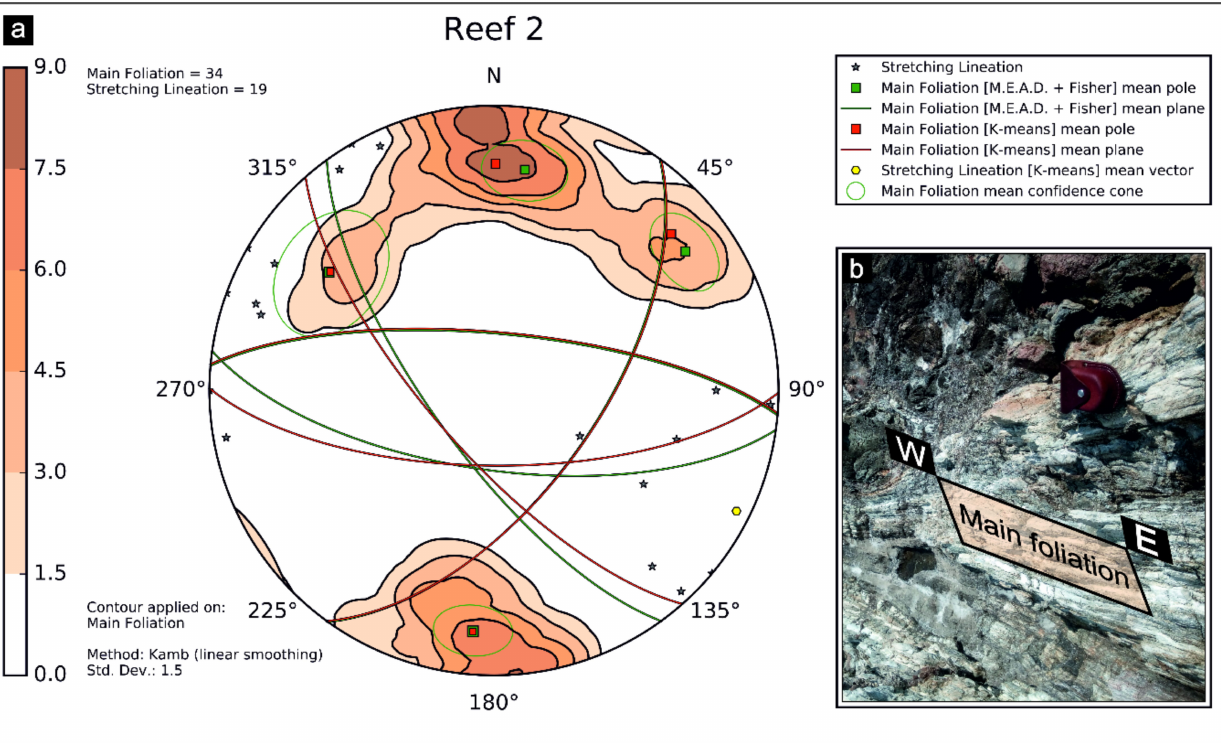
Figure 14. ‘Reef 2 (cid:48) station: ( a ) equal-area azimuthal projection and statistical analysis of main foliations and stretching lineation data and ( b ) field example of mylonitic foliation subparallel to fold axial surface in tonalites. The ASN log file is provided in Appendix B (Table